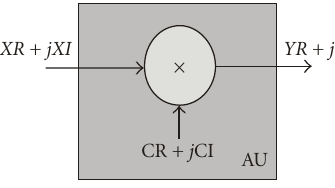
Figure 12: AU configuration for complex multiplication.